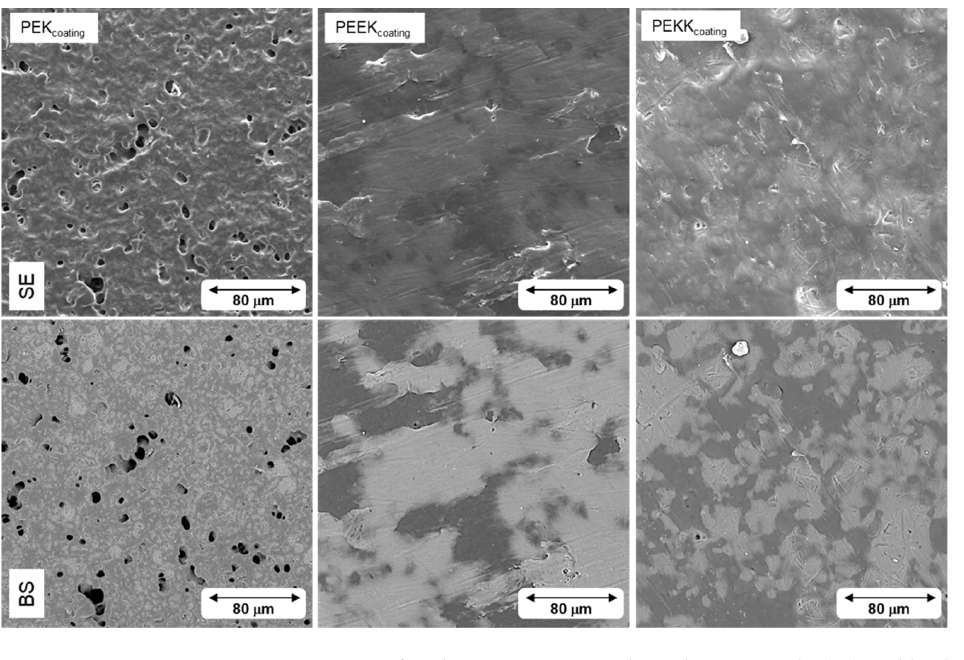
Figure 12. SEM images of each coating in secondary electron mode (SE) and backscattered electron mode (BS).